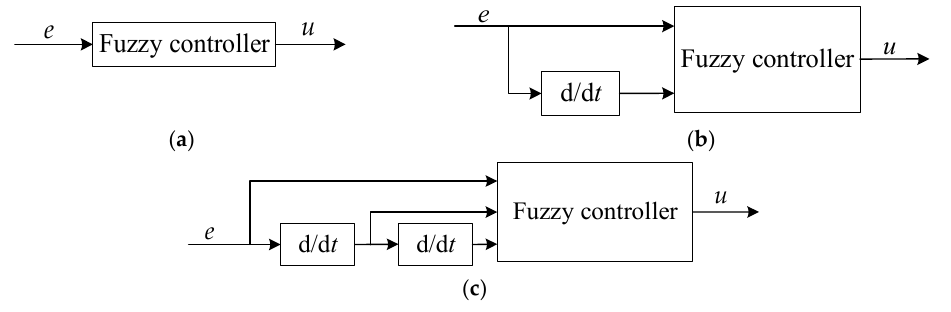
Figure 5. ( a–c ). fuzzy controller with different dimensions.